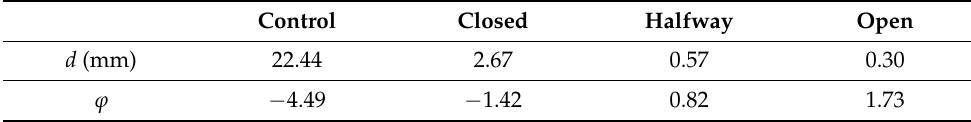
Table 3. Sediment diameter for